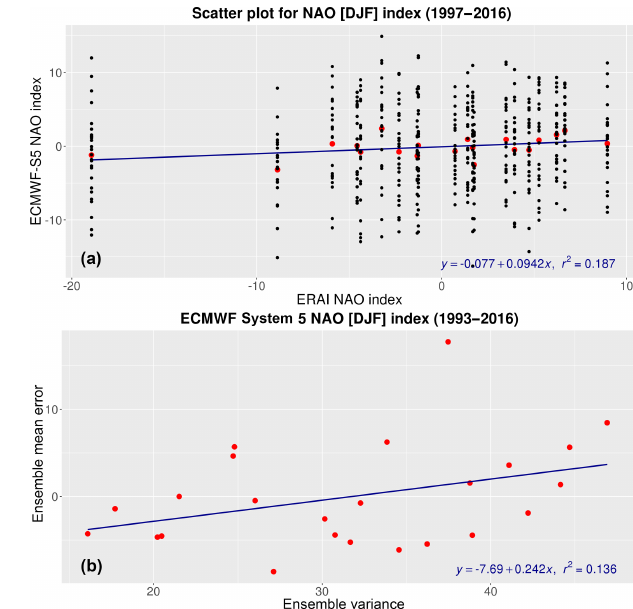
Figure 1. (a) Scatter plot of the winter NAO [DJF] index (aver- aged over December–February) predicted each year between 1997– 2016 by all the 25 ECMWF System 5 ensemble members (black dots) and by the ensemble mean (red dots), versus the NAO [DJF] index obtained from ERA-Interim reanalysis for the correspond- ing year. NAO [DJF] index forecasts have been computed from ECMWF System-5 initialized in October. Horizontal axis repre- sents the range of values of the NAO [DJF] index obtained from ERA-Interim, whereas the y -axis represents the corresponding val- ues of NAO [DJF] index predicted by ECMWF System-5 ensemble members and by the ensemble mean. The fitted regression line (in blue) of NAO [DJF] index predicted by ECMWF System-5 ensem- ble mean versus that obtained from ERA-Interim reanalysis is plot- ted in the figure. (b) ECMWF System 5 NAO [DJF] index ensemble mean error (on the y -axis) plotted versus NAO [DJF] index ensem- ble variance (on the x -axis) each year for the full hindcast period available (1993–2016). Error of the NAO [DJF] index predicted by ECMWF System-5 is calculated each year by subtracting the corre- sponding index obtained from ERA-Interim reanalysis for the same year. The fitted regression line (in blue) is plotted in the